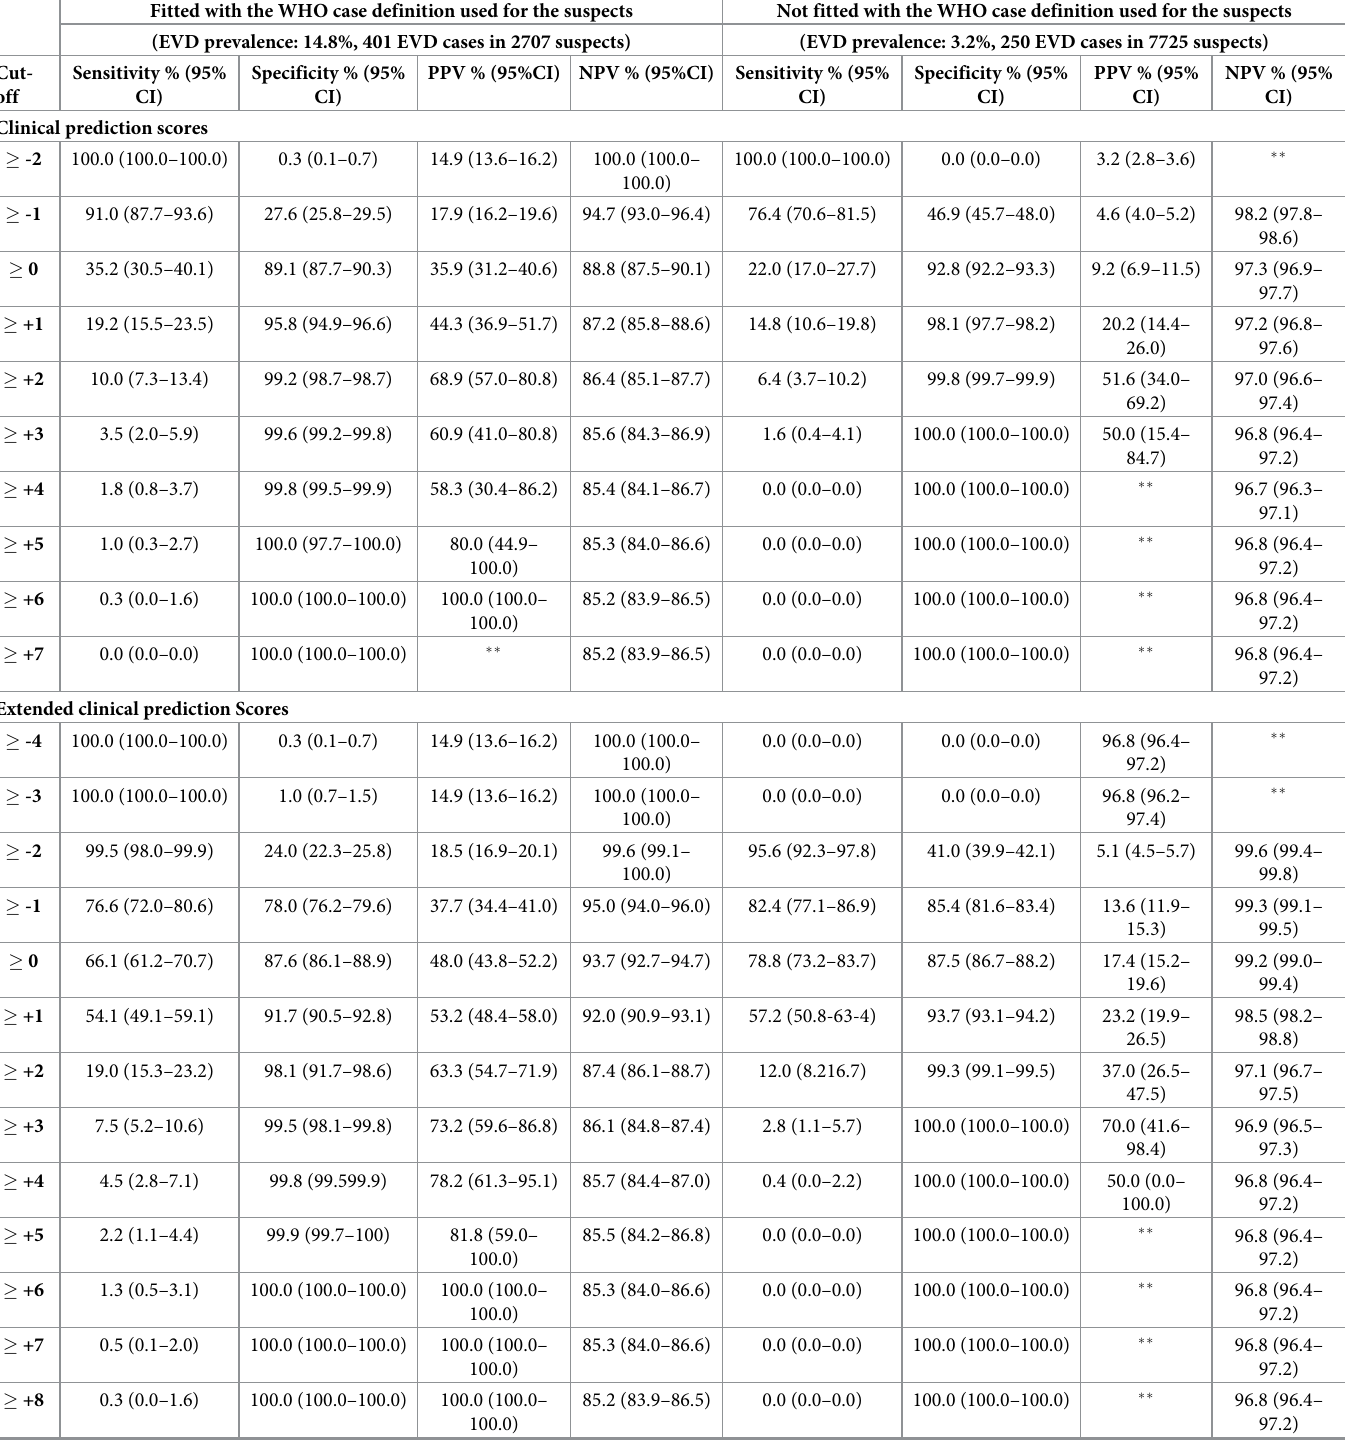
Table 5. Diagnostic performance of extended and clinical prediction scores for screening of Ebola suspects on two subgroups of suspects—those fitting or not fit- ting the WHO case definition. Fitted with the WHO case definition used for the suspects Not fitted with the WHO case definition used for the